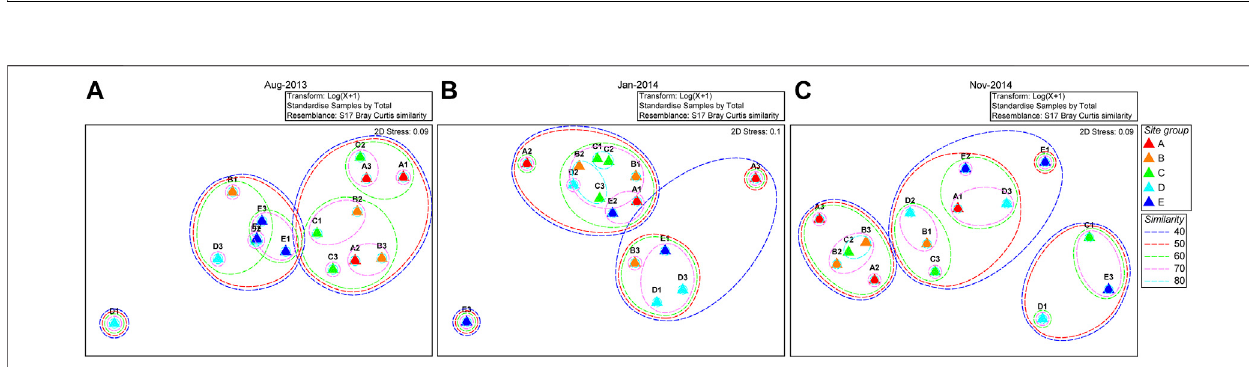
Frontiers in Environmental Science |